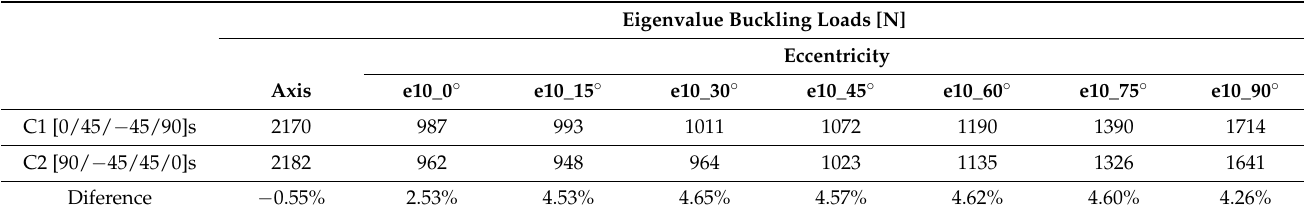
Table 1. Eigenvalue buckling loads of the tested